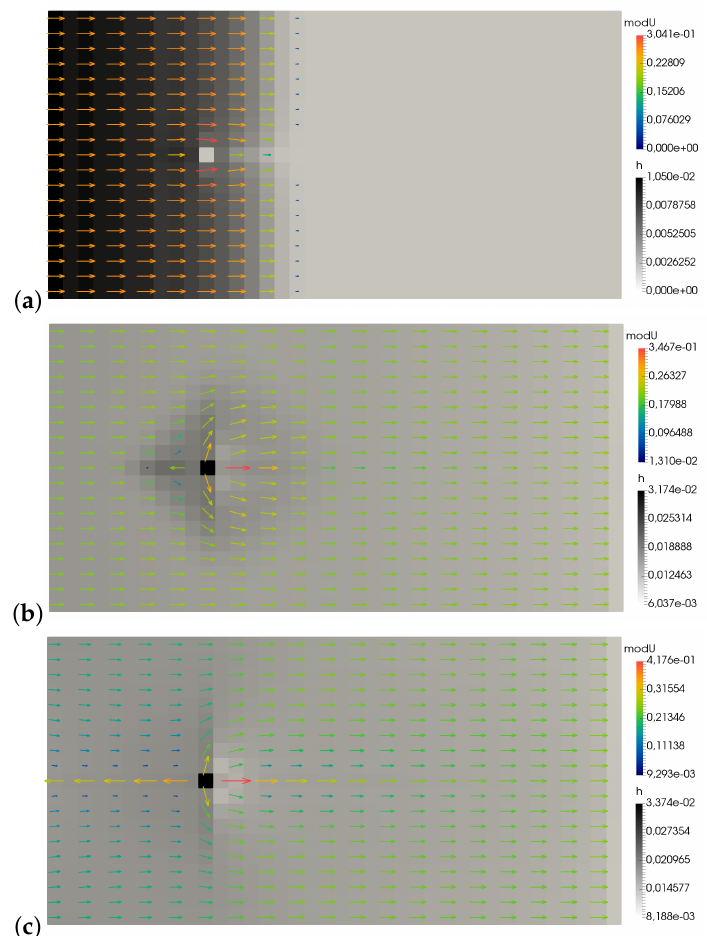
Figure 9. Distributed numerical results for the overland flow corresponding to the water depth in m (grayscale) and the velocity vectors in m/s (colored) at t = 8 s ( a ), 37 s ( b ) and 50 s ( c ).